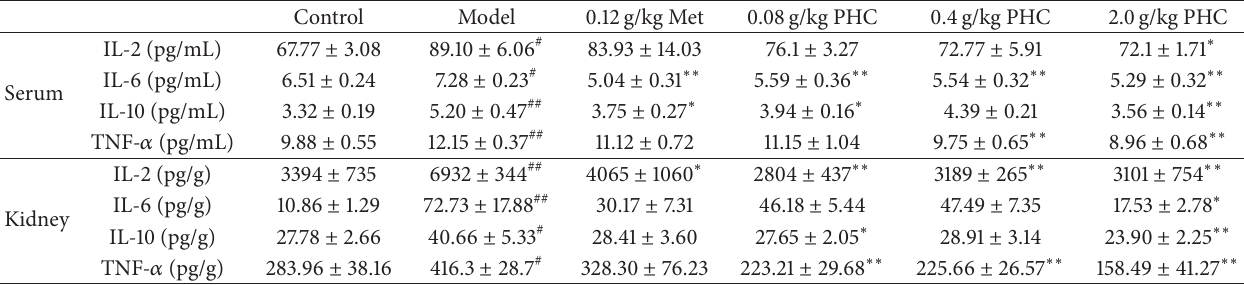
Figure 3: After four-week PHC oral administration, the levels of pyruvate kinase in serum (a) and glycogen in liver (b) were significantly enhanced compared with nontreated diabetic rats. Data are expressed as mean ± SD ( 𝑛 = 10 ) and analyzed by using one-way ANOVA. ## 𝑃 < 0.01 versus control, ∗ 𝑃 < 0.05 and ∗∗ 𝑃 < 0.01 versus model group. Table 2: The regulatory effects of Met and PHC on the inflammatory related factors in diabetic